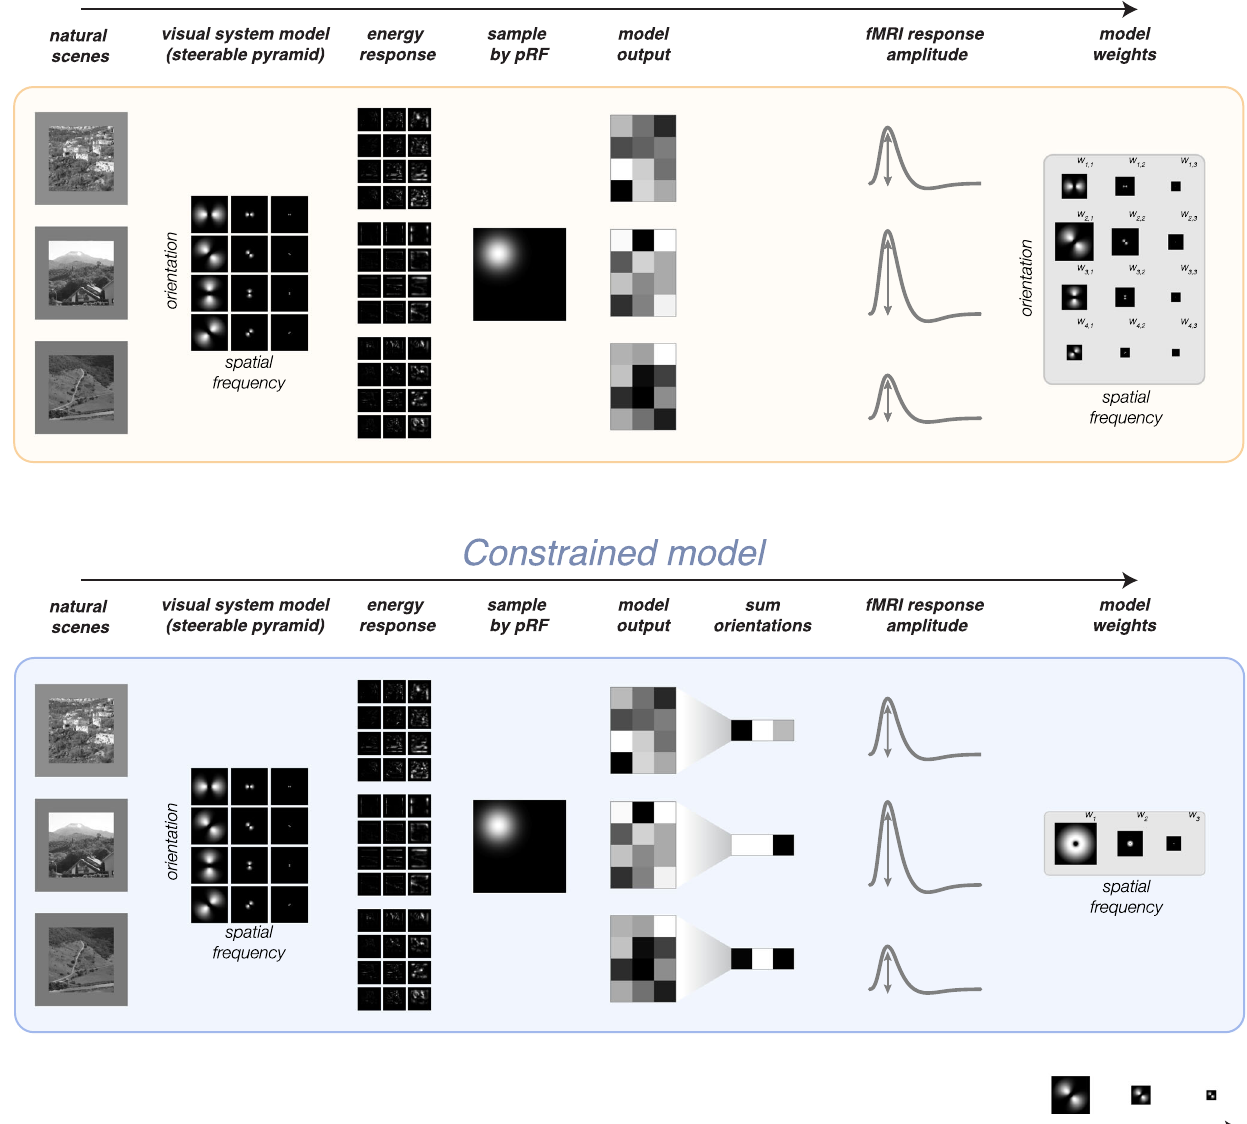
Fig. 1 | Analysis pipeline for a single voxel. Top, full model. Bottom, constrained model. Natural scene images were converted to grayscale and passed as input to a steerable pyramid (shown here with only four orientations and three spatial fre- quencies for visualization purposes). Each fi lter yielded an energy response that was sampled by the voxel pRF, resulting in a scalar output for each fi lter. Linear regression was performed on the response amplitudes observed for each voxel with fi lter output values as predictors. This procedure yielded a set of model